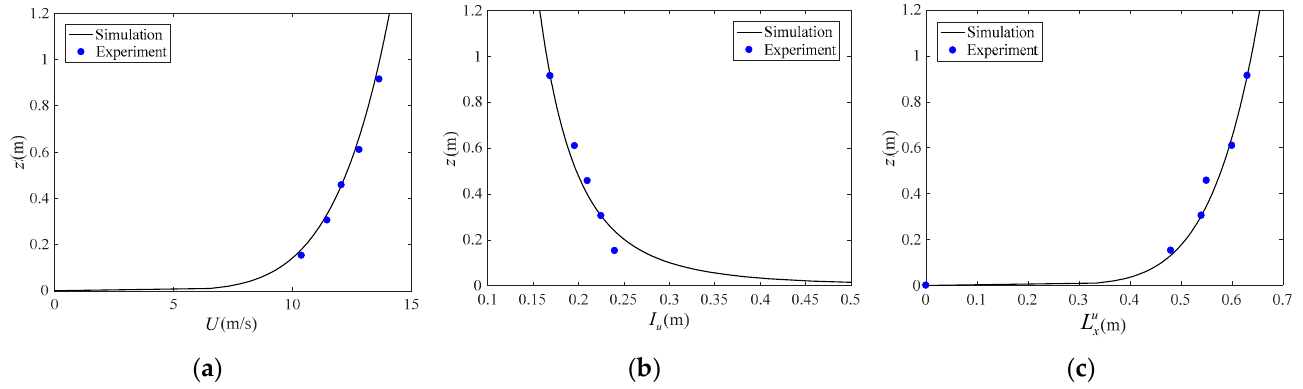
Figure 9. Comparison of turbulence characteristics at the inlet boundary using the exponential form with the experimental values: ( a ) Mean wind speed profile; ( b ) Along − wind turbulence intensity profile; ( c ) Along − wind turbulence integral scale.